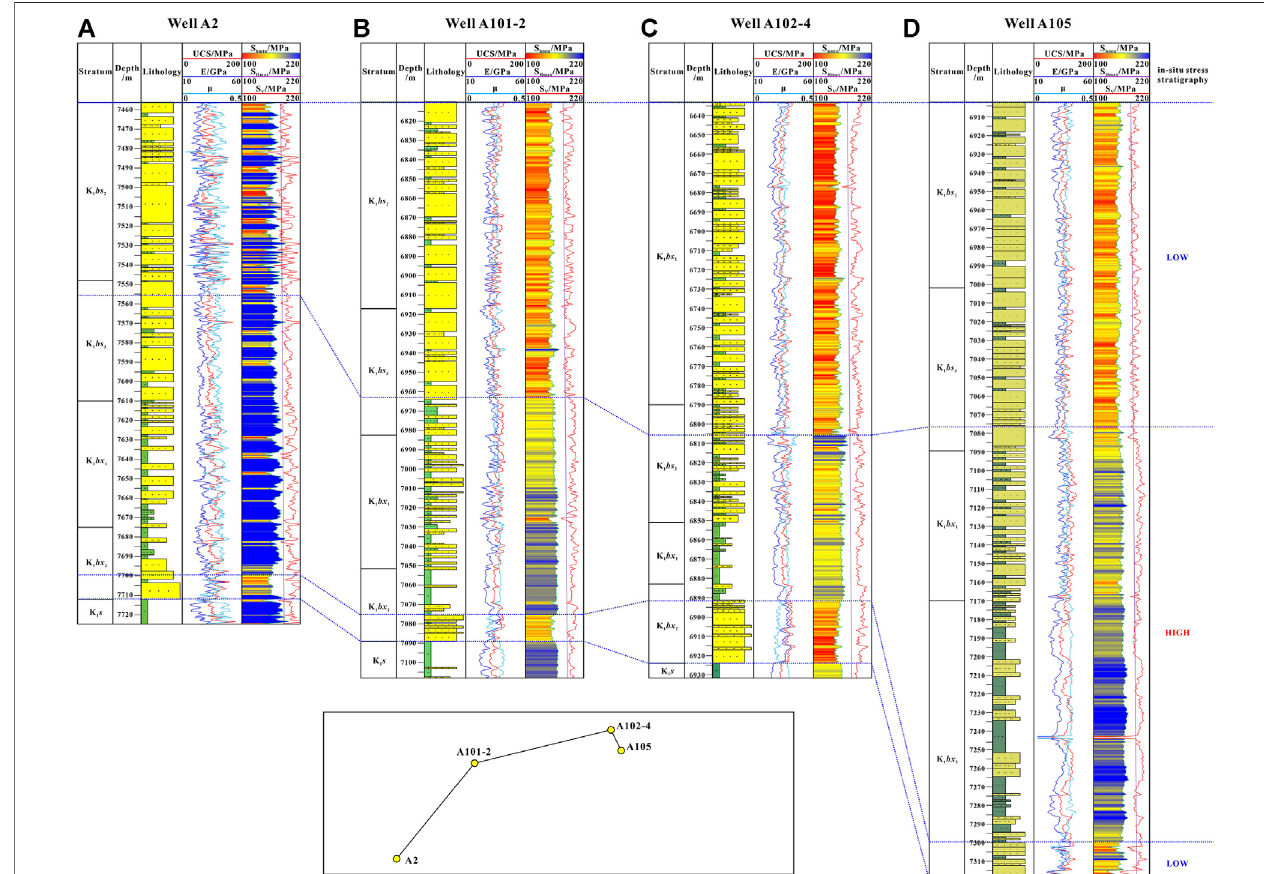
FIGURE 4 | 1D MEM of well A2 – well A101-2 – well A102-4 – well 105.